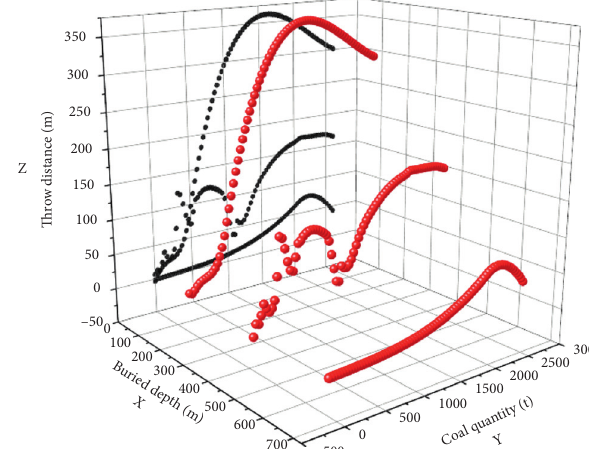
Figure 7: 3D matrix scatter diagram of buried depth, coal quantity, and throw distance and its projection on the YZ plane.